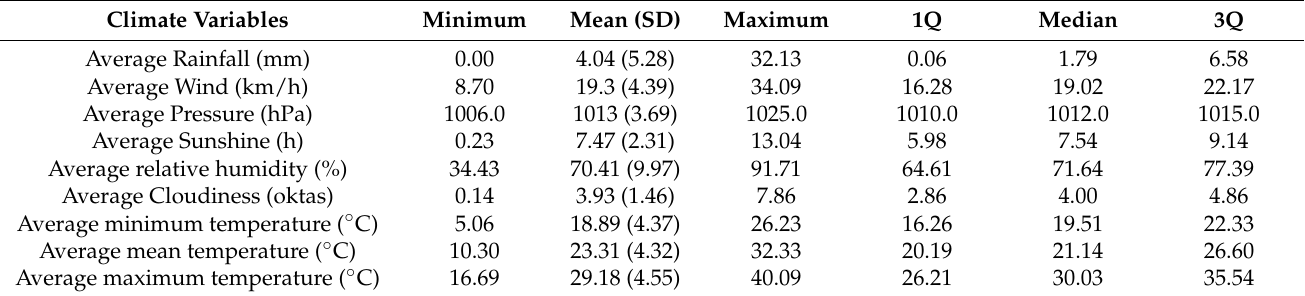
Table 3. Summary of the cross-correlation analysis, Asuncion, Paraguay.